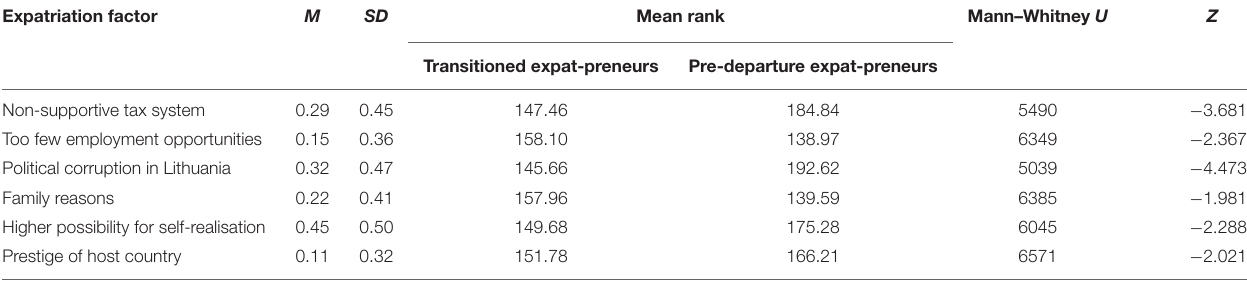
TABLE 4 | Comparative analysis matrix for expatriation